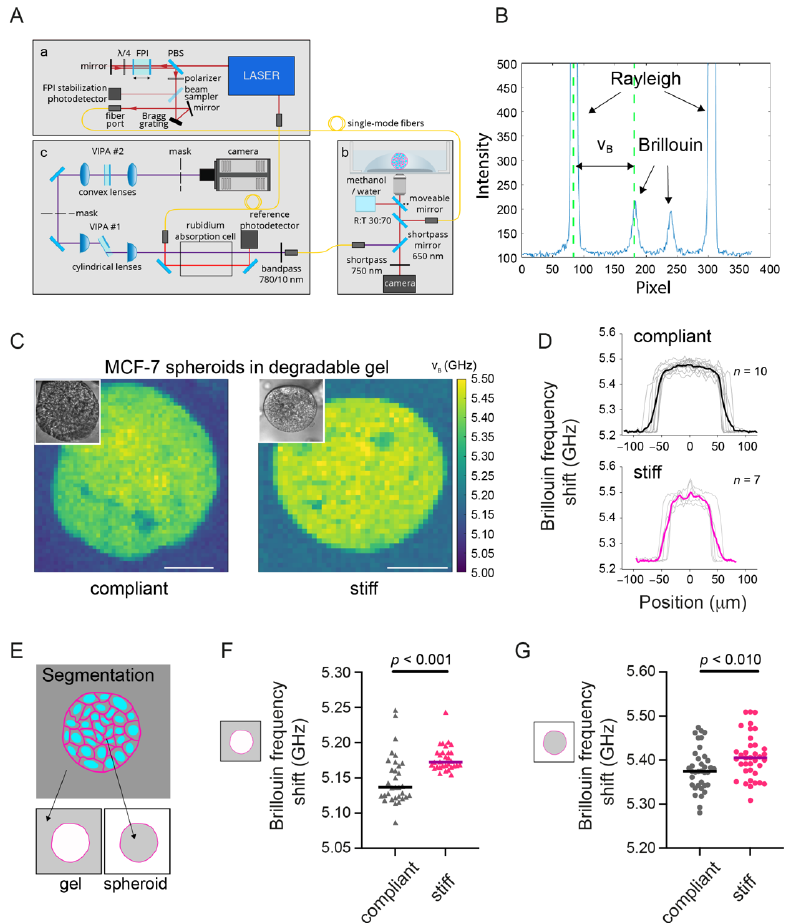
Figure 2. MCF-7 spheroids in stiff degradable hydrogels show an increased Brillouin frequency shift. ( A ) Combined confocal Brillouin microscopy setup. It consists of (a) illumination source, (b) confocal microscope, (c) Brillouin spectrometer. Abbreviations: FPI = Fabry–P é rot interferometer, PBS = polar- izing beam splitter, VIPA = virtually imaged phased array. Adapted from Bakhshandeh et al., 2021. ( B ) Spectrum for a sample obtained from the setup consisting of Rayleigh peaks and Brillouin peaks as highlighted. ( C ) Representative Brillouin maps of MCF-7 spheroids grown in a compliant and bars correspond to 50 µ m. ( D ) Line profiles of the Brillouin frequency shift across spheroids grown area. ( F ) Scatter plot showing Brillouin frequency shifts for compliant and stiff degradable hydrogels. n = 31–32 spheroids each. Medians are indicated by a line. ( G ) Brillouin frequency shifts for